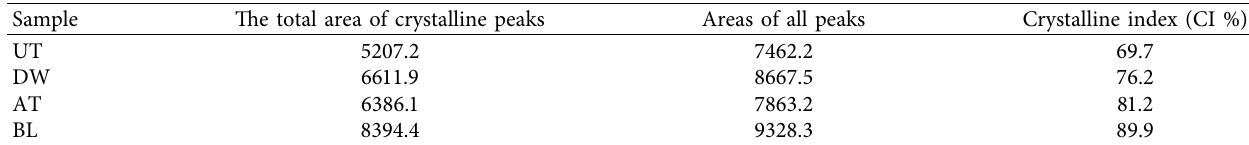
Table 4: Crystalline index of UT, DW, AT, and BL samples.